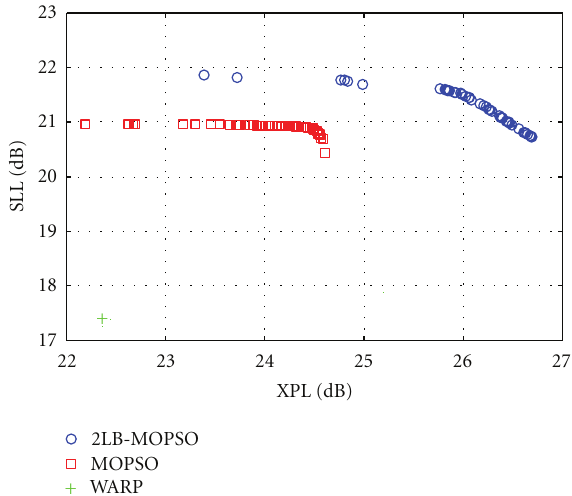
Figure 2: Pareto fronts obtained by the 2LB-MOPSO and MOPSO.